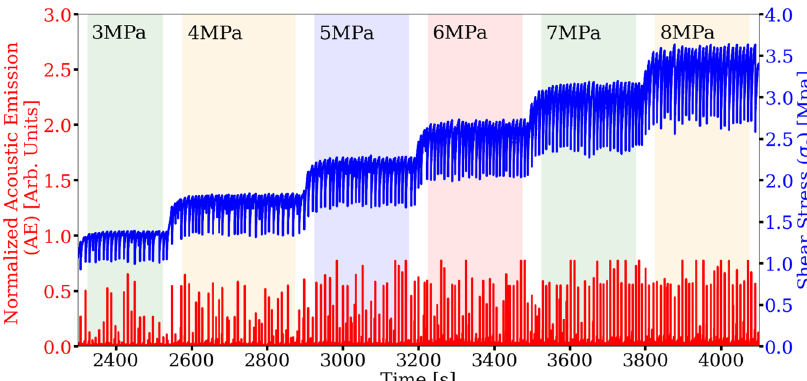
Fig. 6 Convolutional encoder-decoder (CED) model generalization. The cross-trained model is rigorously validated using a second laboratory experiment (p4581) as an independent data set. The input signal is the acoustic emission (AE in red, left axis) and the target signal is the friction derived from the shear stress ( σ s in blue, right axis) at progressively increasing applied normal loads (3 – 8 MPa), shown in sequence and delineated by different